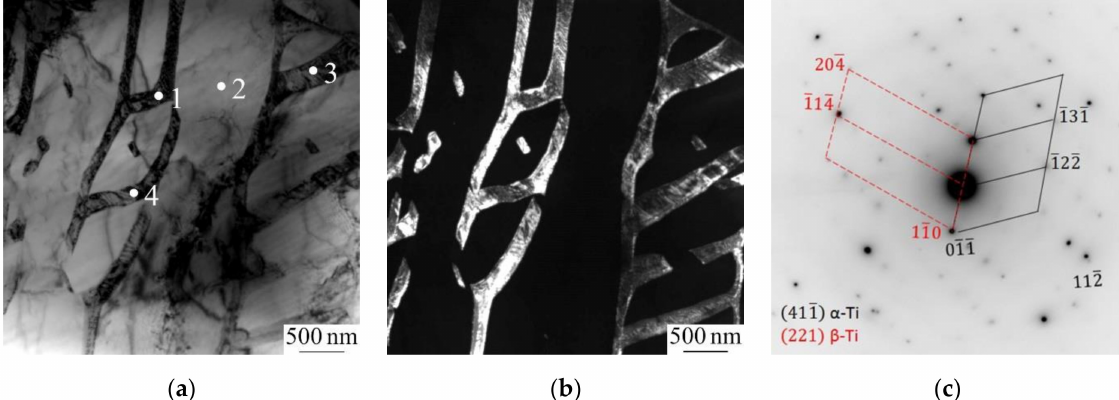
(cid:0) (cid:1) α 411 -Ti and 110 ( 221 )